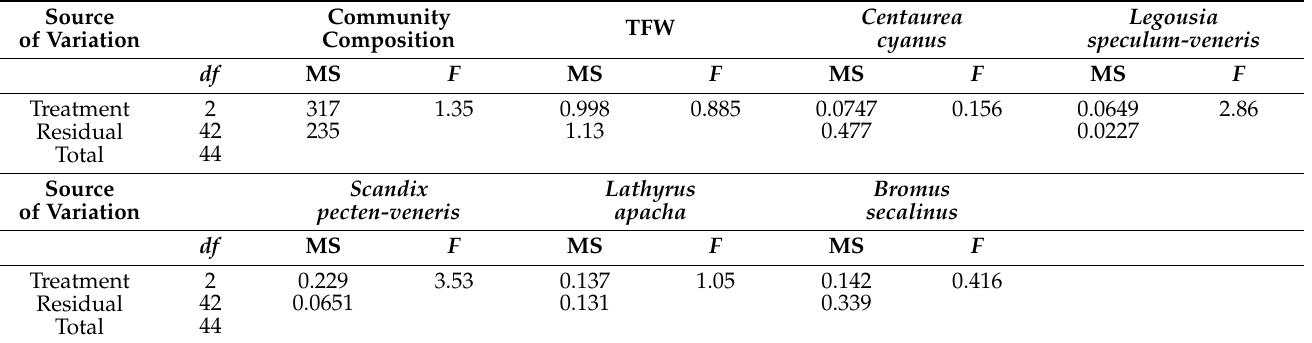
Table 7. Results of the PERMANOVA analyses on community composition with the fresh weight of each species as an abundance measure, on the total fresh weight per pot (TFW), and on the fresh weight of single species per